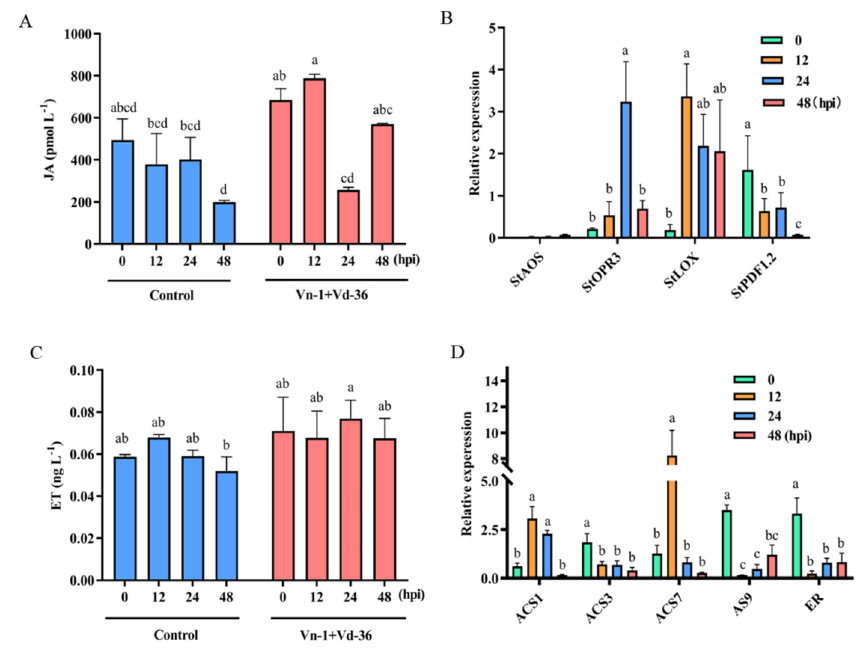
Figure 5. Jasmonic acid (JA)/ethylene (ET) signalling pathways were weakly activated by Vn ‐ 1 in potatoes: ( A , C ) salicylic acid (SA) content at different times during the control and Vn ‐ 1+Vd ‐ 36 treatments. The experiment was setup in three replicates with three potato plants per replicate, and